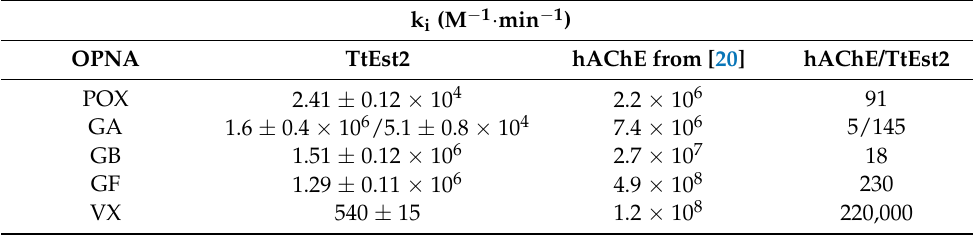
Table 1. Bimolecular rates of inhibition (k i ) of TtEst2 for various